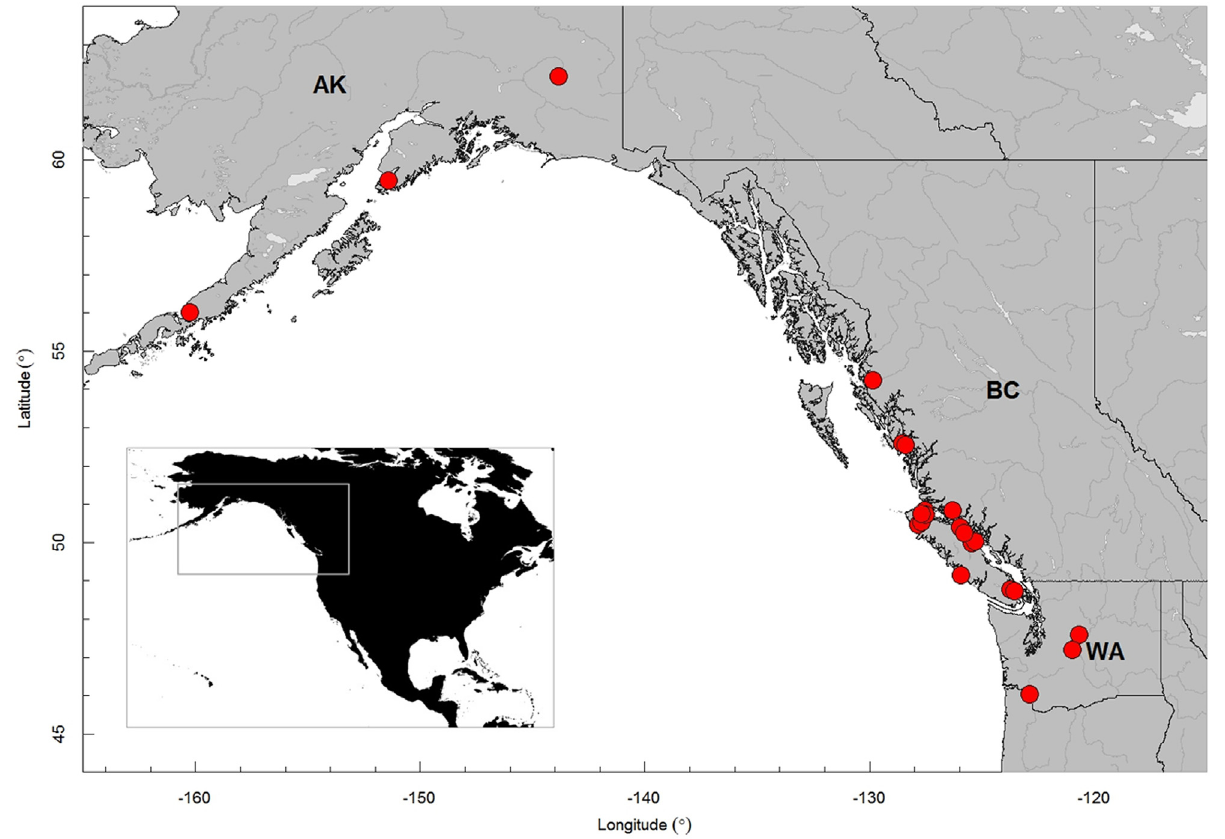
Fig 1. Map of Canada/US Pacific coast showing the geographic localisations where the salmonids were sampled. AK: Alaska (United States of America); BC: British Columbia (Canada); WA: Washington State (United States of America).